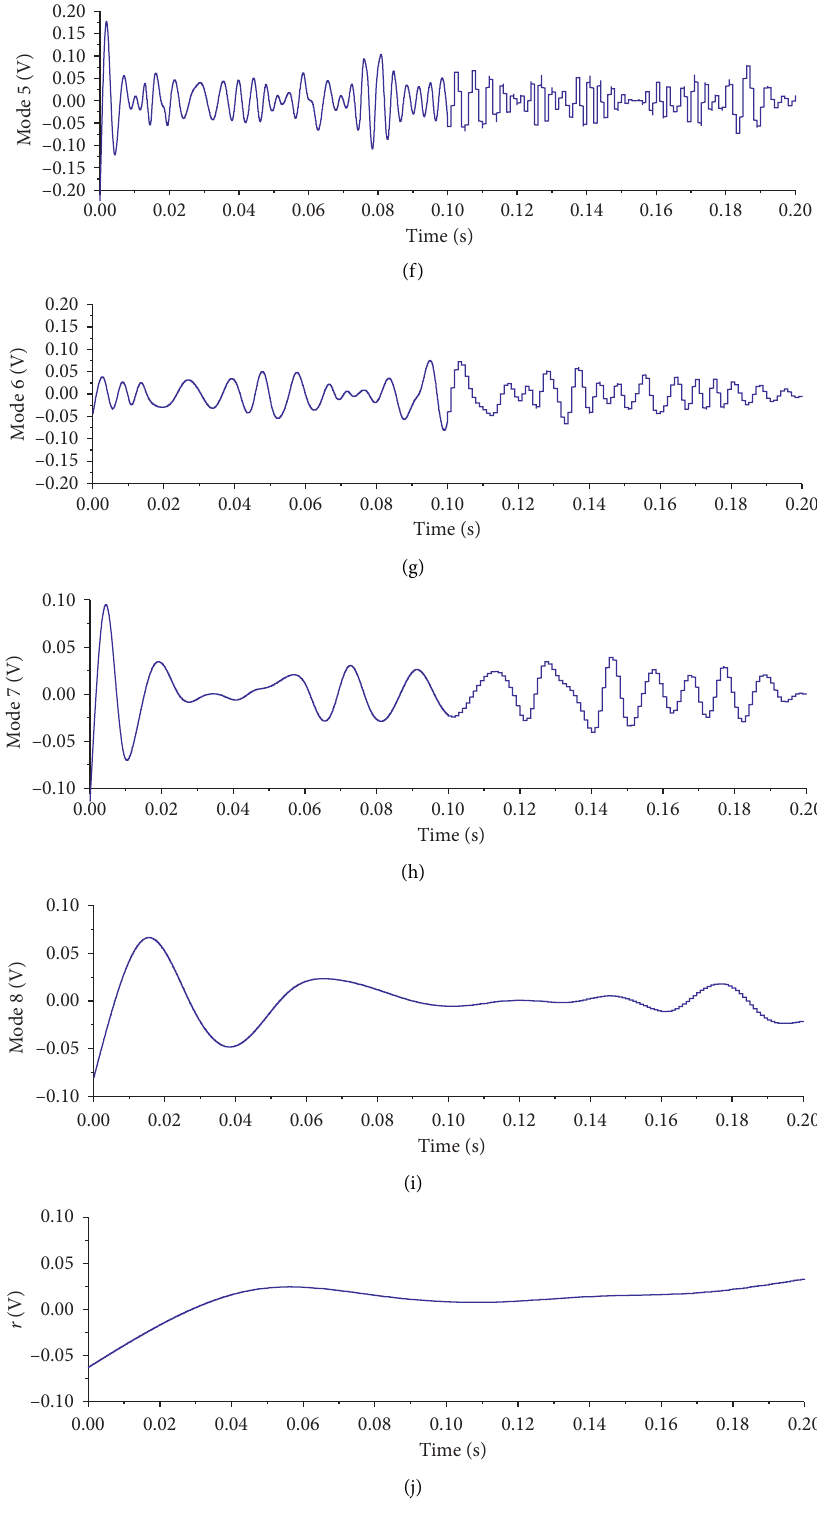
Figure 11: Results of ESMD for swash plate